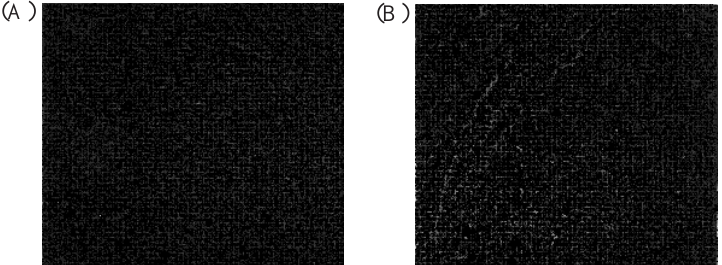
Fig. 3. CD64 staining in human tonsil. Tissue was fixed in (A) Histochoice or (B) NBF (DAB chromogen, 100 × ). Equal staining intensity produced with Histochoice and NBF.